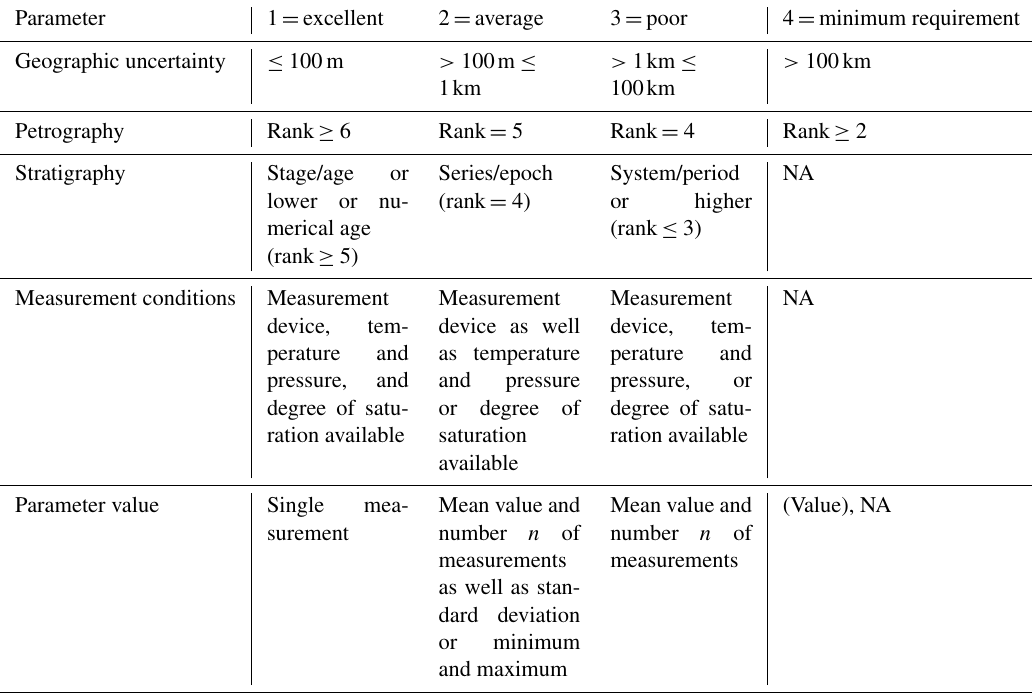
Table 3. Quality indices defined by the input data available ( n : numbers of measurements, NA: not available). Parameter 1 = excellent 2 = average 3 = poor 4 = minimum requirement > 1km ≤ > 100km Geographic uncertainty ≤ 100m > 100m ≤ 1km 100km Petrography Rank ≥ 6 Rank = 5 Rank = 4 Rank ≥ 2 Stratigraphy Stage/age or lower or nu-